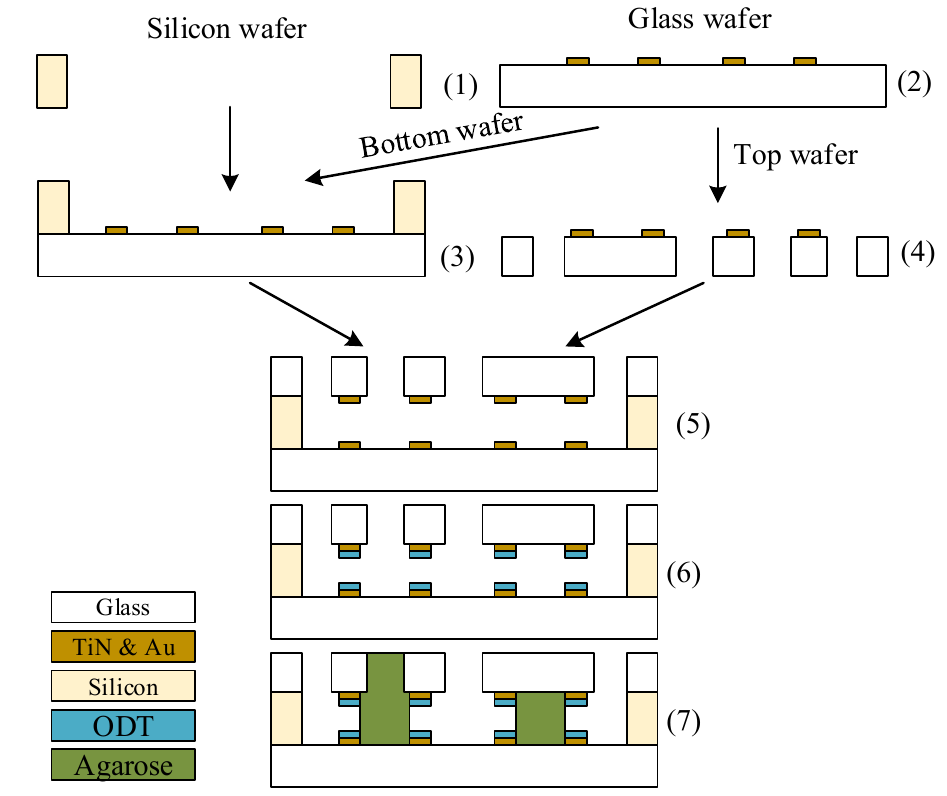
Figure 4. Fabrication of the device: (1) Deep reactive ion etching (DRIE) process for the channels into 380µm thick silicon; (2) patterning of titanium nitride and gold on two 520µm thick borosilicateglass wafers; (3) anodic bonding of one glass wafer and the silicon wafer; (4) powderblasting of the inlets into the second glass wafer; (5) anodic bonding; (6) coating of gold with octadecanethiol (ODT); (7) creation of the agarose